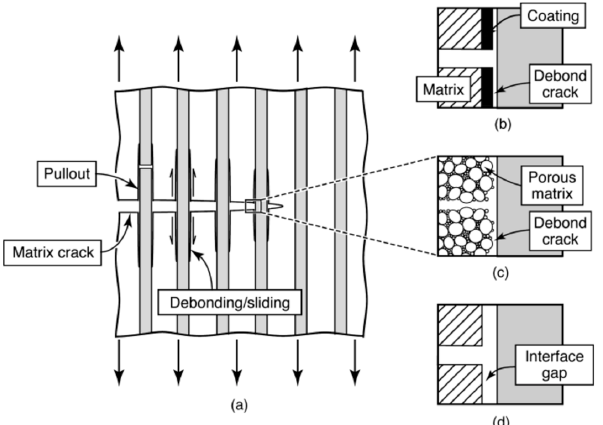
Figure 1. (a) The reinforcement mechanisms for continuous-fiber ceramic composites. ( b ) Using a fiber coating to create a weak interface, ( c ) creating a weak matrix through fine-scale matrix porosity, and ( d ) using fugitive coatings that will be volatilized by oxidation and leave a narrow space between the fiber and matrix, as described in